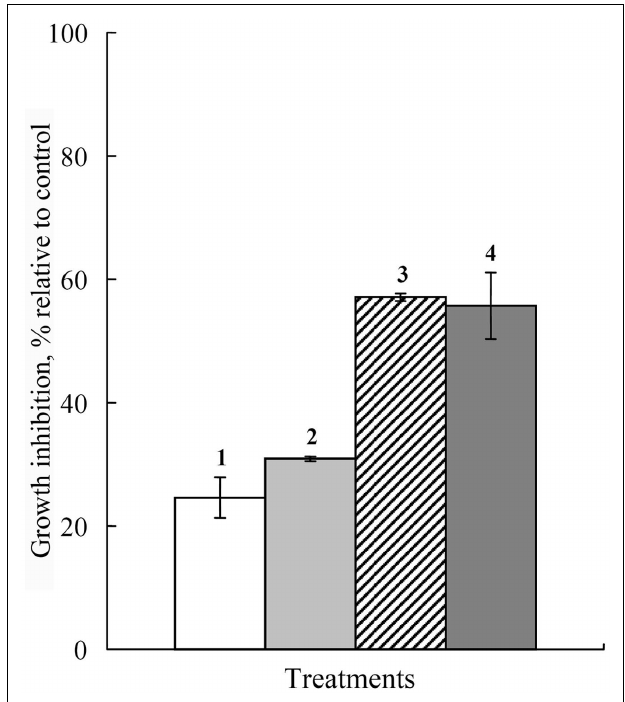
FIGURE 2 | Histograms showing percent growth inhibition of S. nodorum on PDA-media supplemented with thymol alone, the fungicide Dividend alone, or with Dividend + thymol as compared to controls (0% inhibition). ( 1) Thymol, 10ppm alone; ( 2) Dividend, 1ppm alone; ( 3) Dividend, 1ppm + thymol, 10ppm; ( 4) Dividend, 10ppm. Bars represent SE.